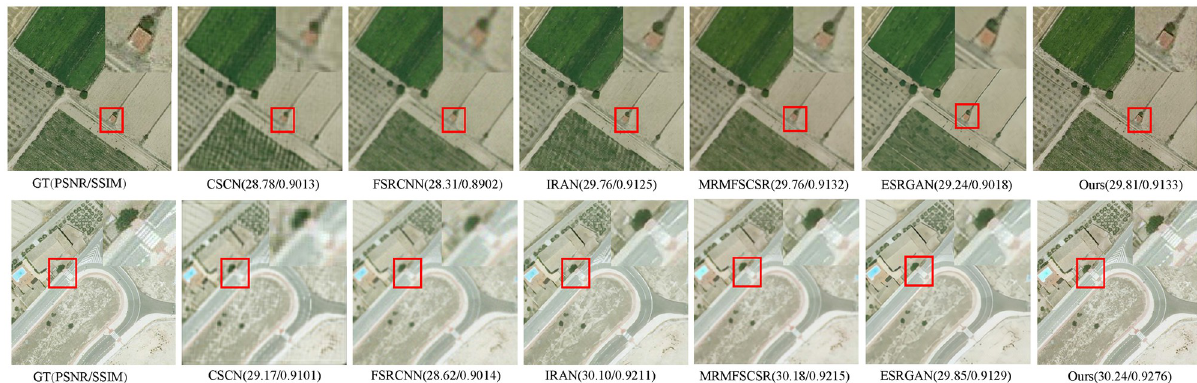
Fig 6. The visual comparison of Test20 dataset SR obtained using different methods with an up-scaling factor 4.